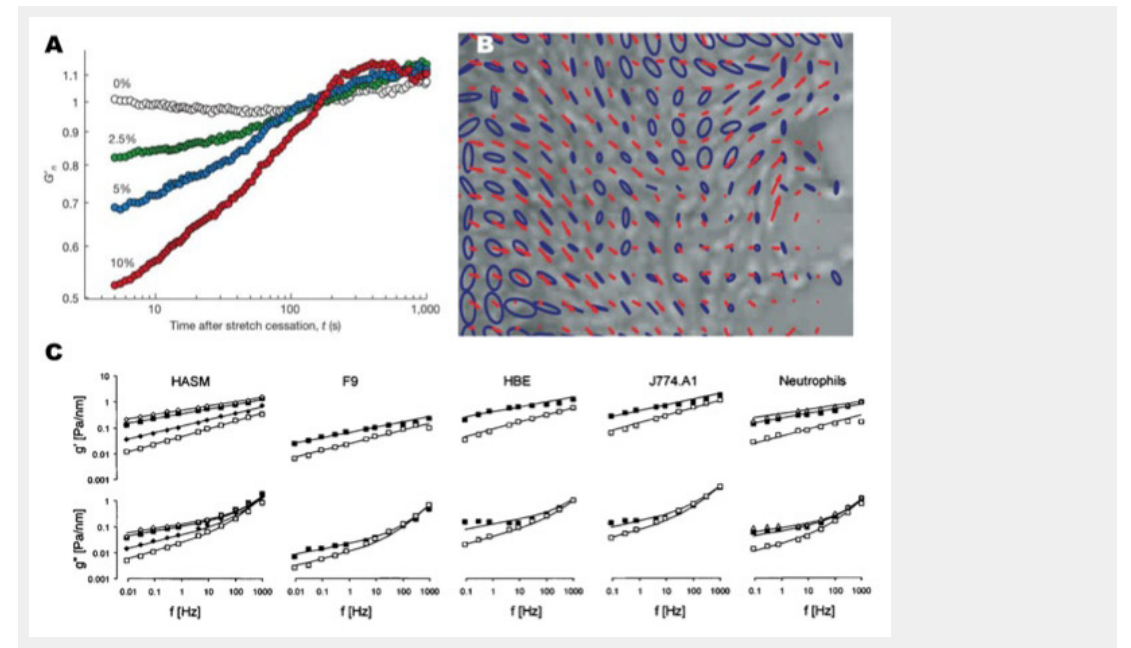
Figure 2 Emergent cell mechanical properties. (A) Cells have been observed to fluidise and resolidify in response to stretch regardless of stretch magnitude. (B) Plithotaxis describes the phenomenon of cells migrating so as to minimise shear stress on their cell-cell junctions, depicted in the alignment between velocity vectors (red line) with the principal stress orientation (blue ellipses). (C) Multiple cell types exposed to a series of biological perturbations have all been observed to exhibit a power-law behaviour, a characteristic of soft glassy materials. Adapted with permission from Tambe et al. Nat Mater. 2011;10(6):469–7 [14], Trepat et al. Nature. 2007;447(7144):592–5 [29], and Fabry et al. Phys Rev E Stat Nonlin Soft Matter Phys. 2003;68(4Pt1):041914